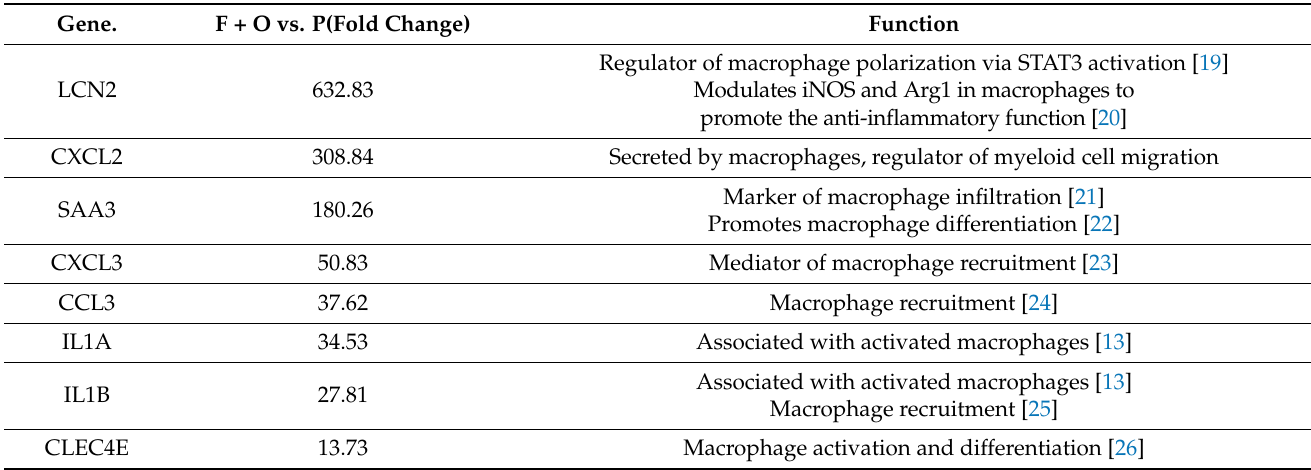
Table 1. Macrophage-associated genes highly upregulated by FEC + oHSV-1 therapy.